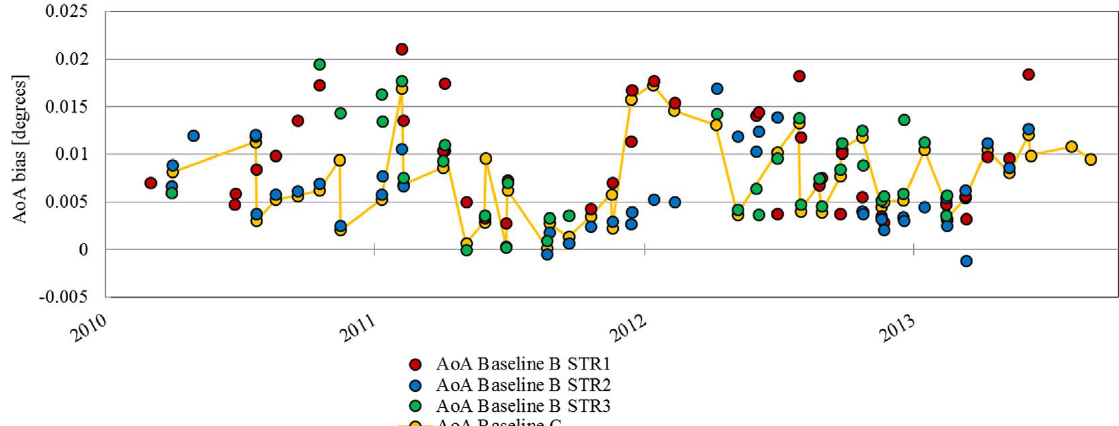
Figure 5. Baseline-B and Baseline-C AoA results. Read, blue and green points represent the individual AoA retrievals for Star Trackers (STRs) 1, 2 and 3. Yellow dots represent the retrieval of the STR selected by the STR processor. Figure taken from [8].